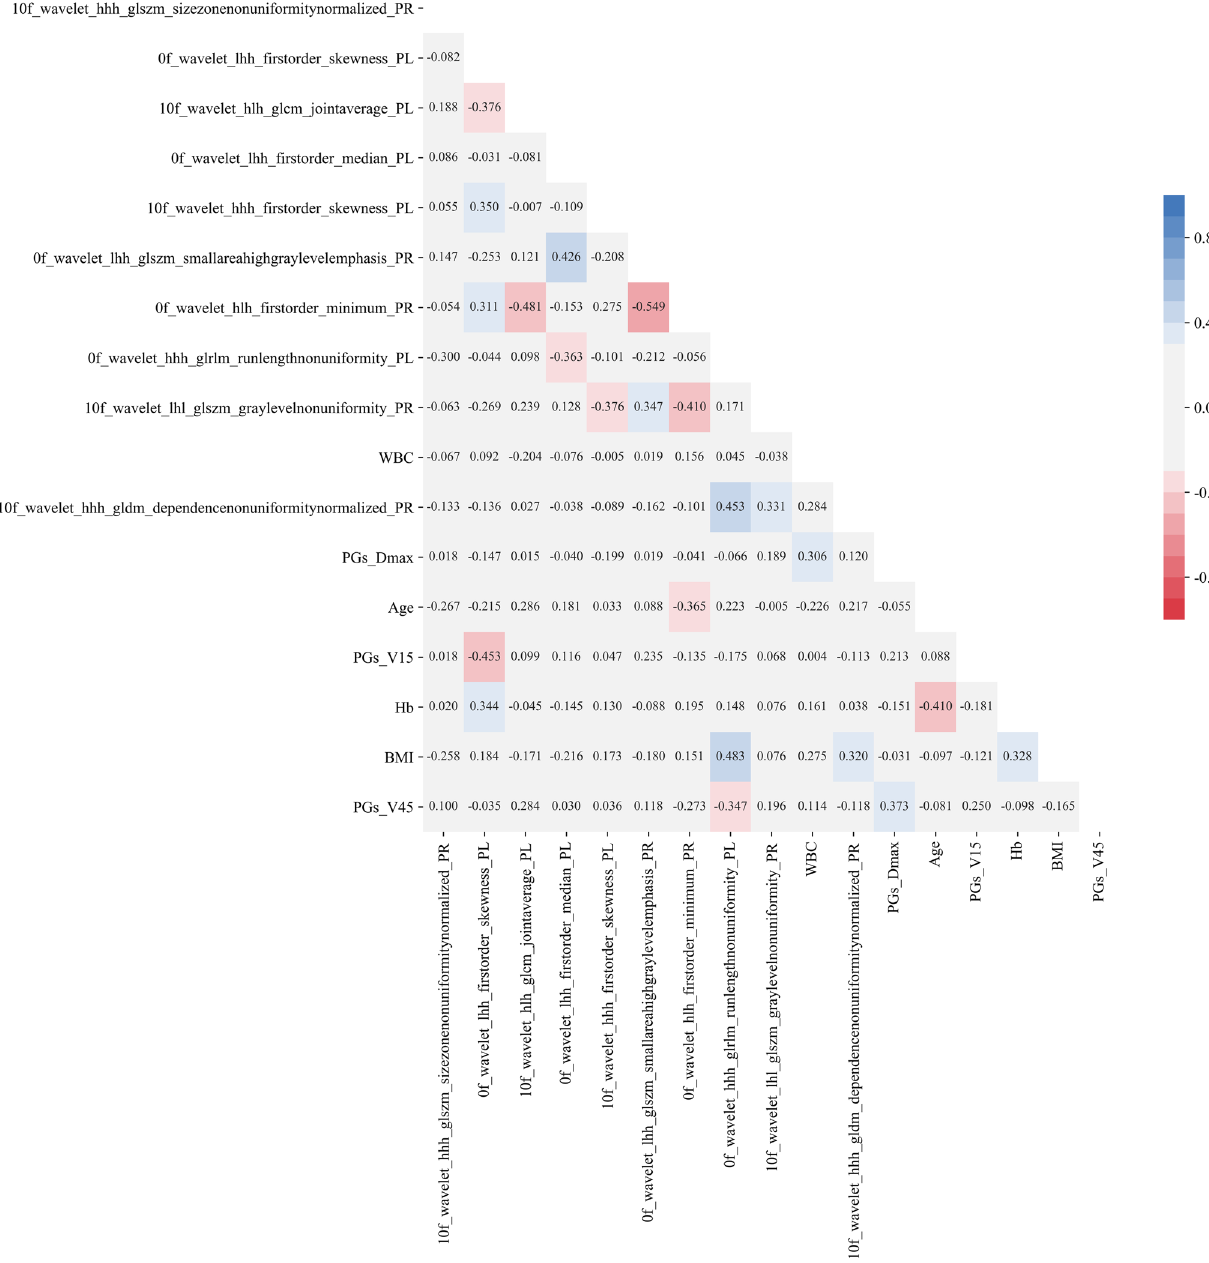
Fig. 4 Pearson correlation heat map of top 17 integrated